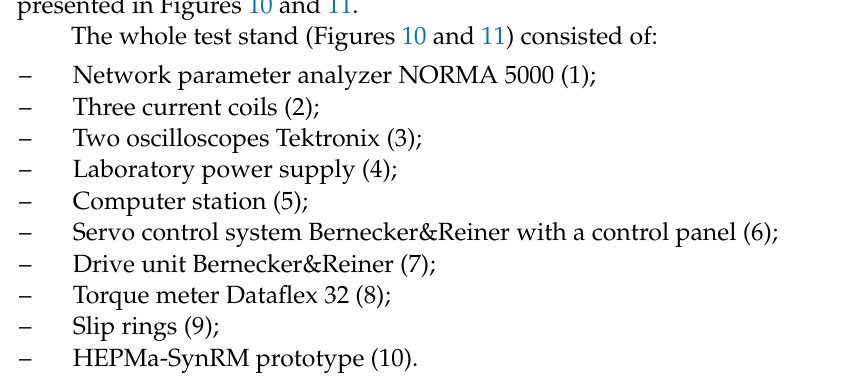
Figure 9. Electromagnetic torque with different currents in stator and DC coils.